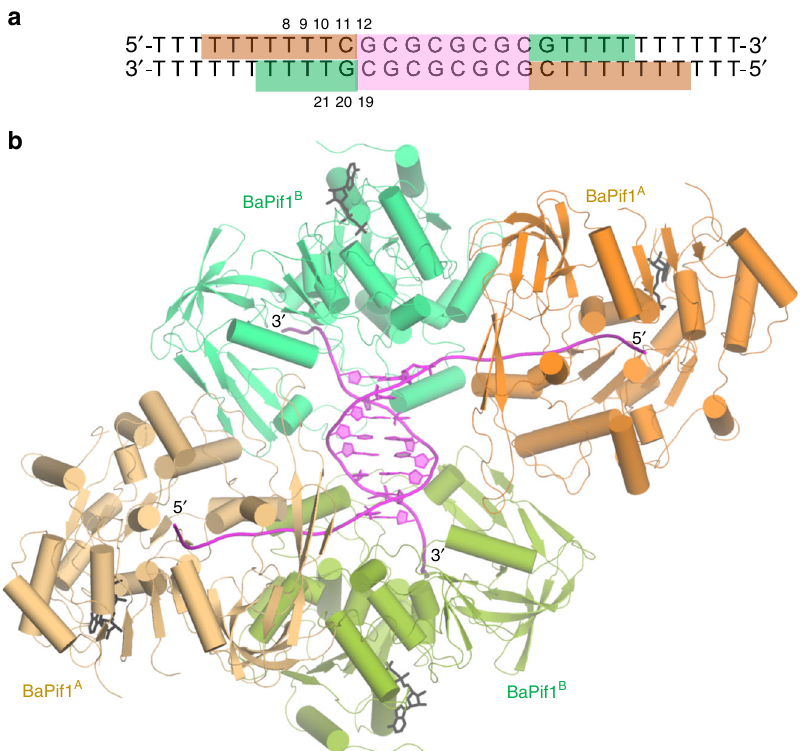
Fig. 1 Structure of BaPif1 complexed with a dual forked dsDNA. a DNA sequence used for crystallization: The eight out of the ten nucleotide base pairs of the central dsDNA observed in the structure are shown in violet. The brown and green blocks correspond to nucleotides bound to BaPif1 at 5 ′ and 3 ′ arms of the dual forked dsDNA. The nucleotides discussed in the text are numbered. b Structure of BaPif1 bound to dual forked dsDNA: Molecules at 5 ′ arms labeled as BaPif1 A and shown in two shades of brown, are related by a two-fold symmetry axis. Similarly, molecules at 3 ′ arms labeled as BaPif1 B and shown in two shades of green, are related by the same two-fold axis. The asymmetric unit consists of two molecules of BaPif1 (one in green and the other in brown) and one strand of DNA. ADP·AlF 4 − used in crystallization is shown as black